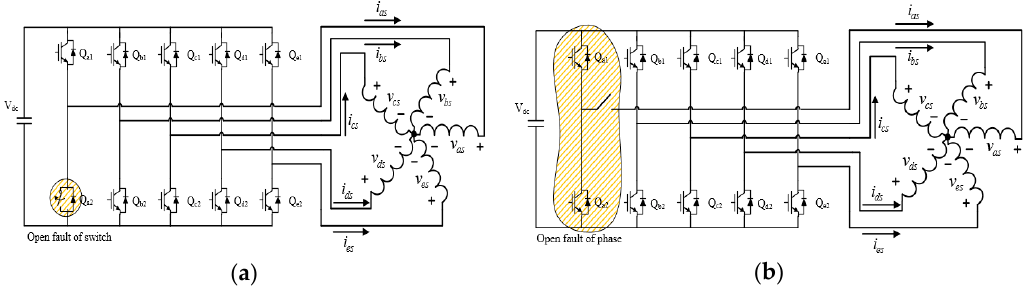
Figure 1. Fault type of five ‐ phase inverter: ( a ) Fault of one switch; ( b ) Fault of one leg.